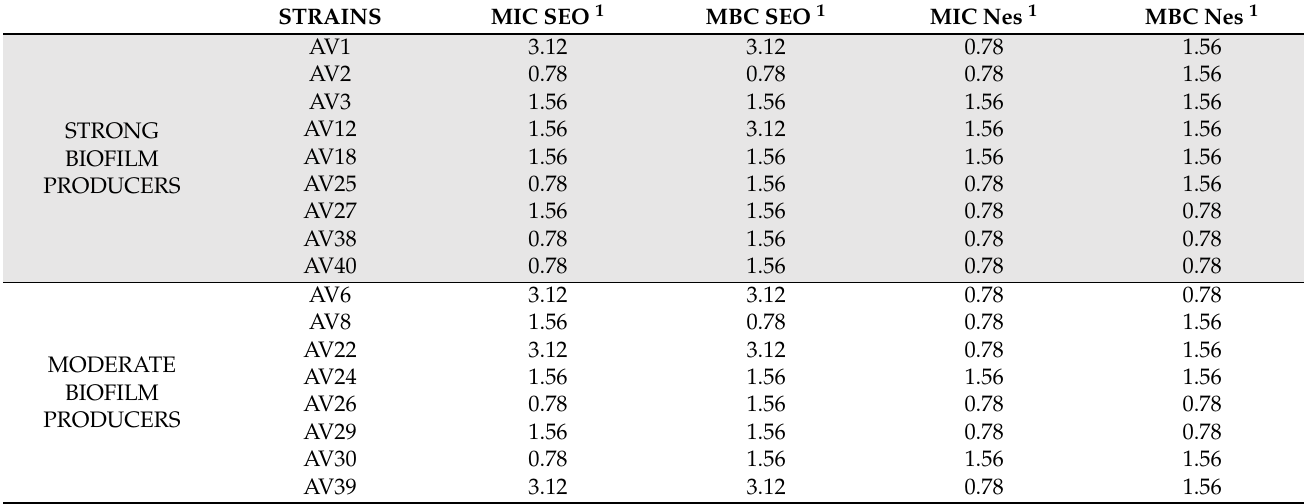
Table 4. Minimum inhibitory concentrations (MICs) and minimum bactericidal concentrations (MBCs) comparison between SEO and